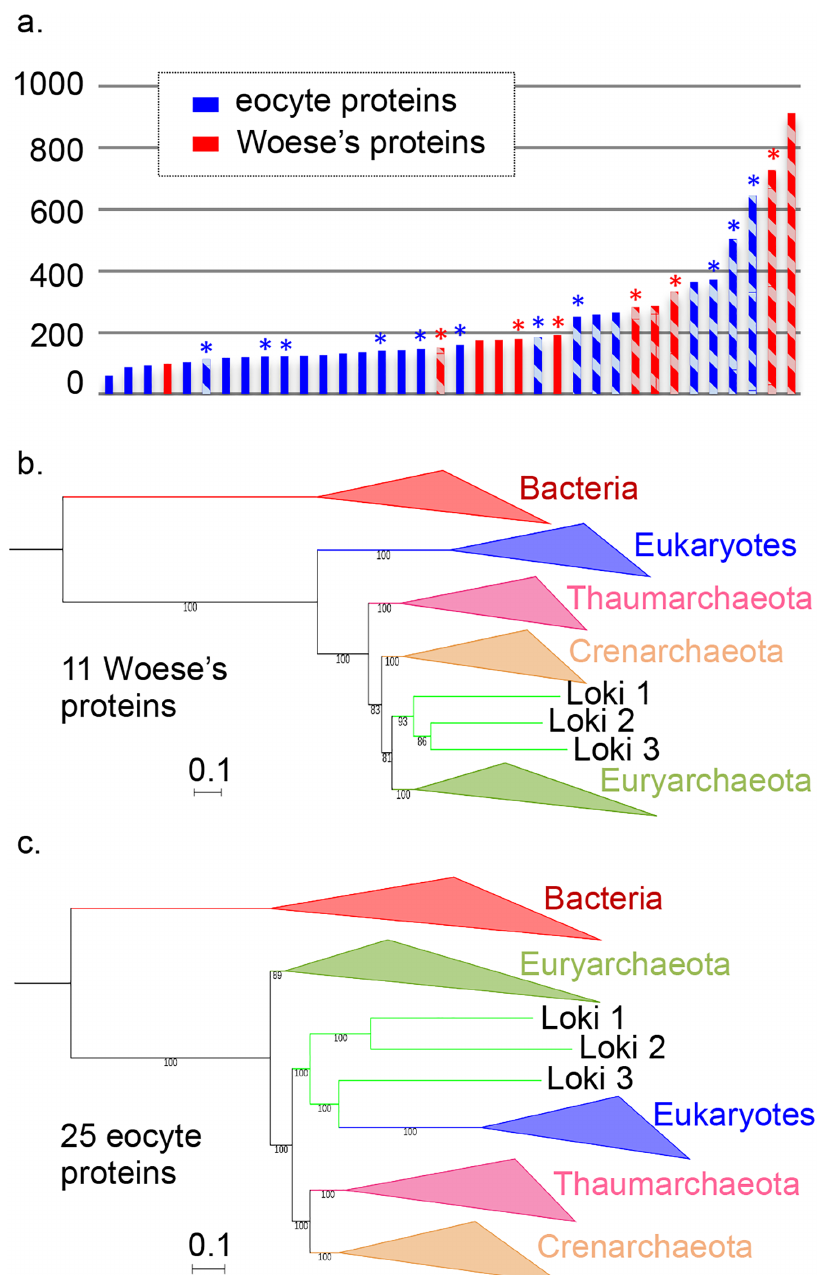
Fig 1. Comparison and concatenation of different subsets of the 36 universal proteins. a. Diagramof the amino-acid lengthsof the 36 universalproteins, obtained after alignmentand trimming from the curated dataset (details in S1 Table). Ribosomal and non-ribosomal proteins are indicatedin solid and hashed-bars, respectively. The markers for which the monophylyof Archaea was obtainedin their phylogenetic tree are indicatedin red, whereasthose related to the paraphylyof Archaea are indicatedin blue. * indicates alignments that statistically support in AU test the Woese’s or eocyte topology(in red and blue, respectively) b. Maximum Likelihood (ML) phylogenetic tree of the concatenation of the 11 Woese’s proteins(3,499 positions). c. ML phylogenetictree of the concatenation of the 25 eocyte proteins (4,868 positions). Detailed trees in S3 and S4 Figs. The scale-bars represent the averagenumberof substitutionsper site. Values at nodesrepresent support calculatedby nonparametric bootstrap (out of 100).